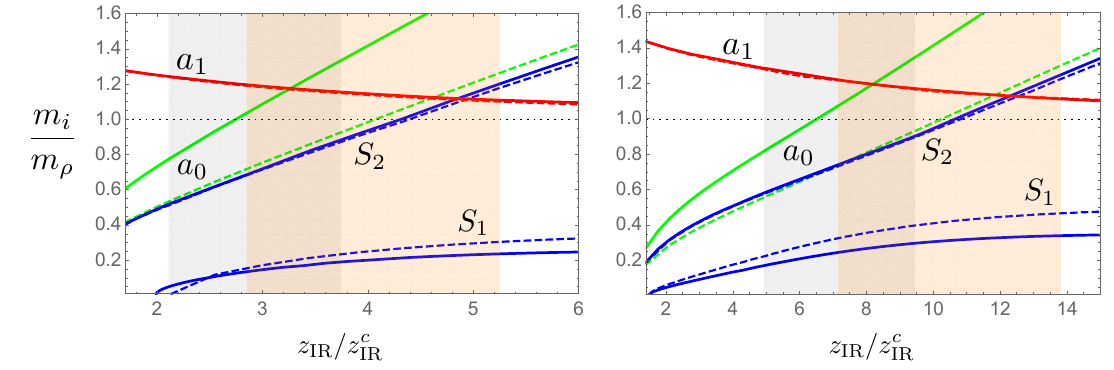
Figure 7 . Masses of the two lightest singlet scalars, S 1 and S 2 , lightest adjoint scalar ( a 0 ), lightest axial-vector ( a 1 ) normalized to the lightest vector mass ( m (cid:26) ) for constant F (cid:25) (cid:24) m (cid:26) = 7 as a function of z IR =z c for (cid:21) = 1. We have taken ^ (cid:20) 2 = 1 (4) for solid (dashed) lines. The left grey (right orange) IR band corresponds to the region 0 : 5 < g 2 ^ m 2 < (cid:0) 2 that we will discuss later ((cid:12)gure 8). Finally, g 2 b